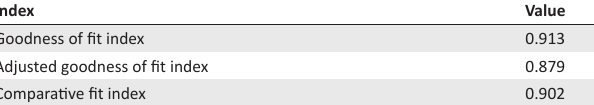
TABLE 6: Goodness of fit indices initial model.